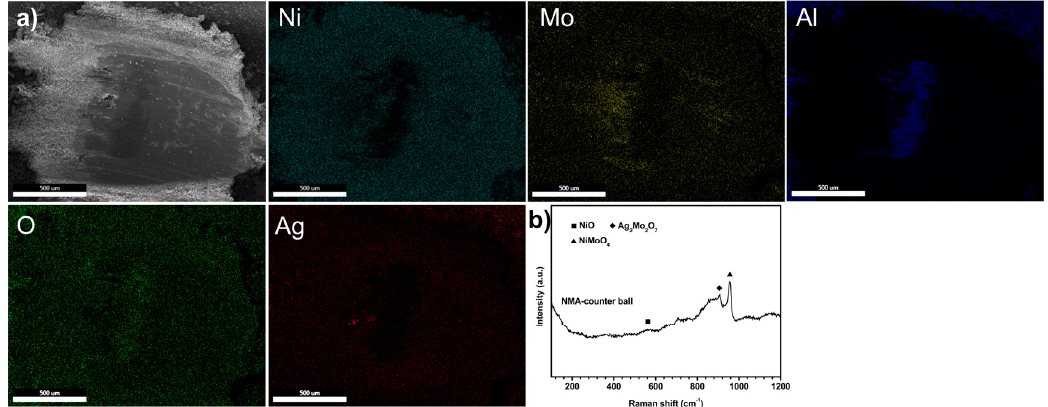
Figure 10. ( a ) EDS and ( b ) Raman spectra of the Al 2 O 3 counter ball, mating with NMA self-lubricating a composite at 800 °C.